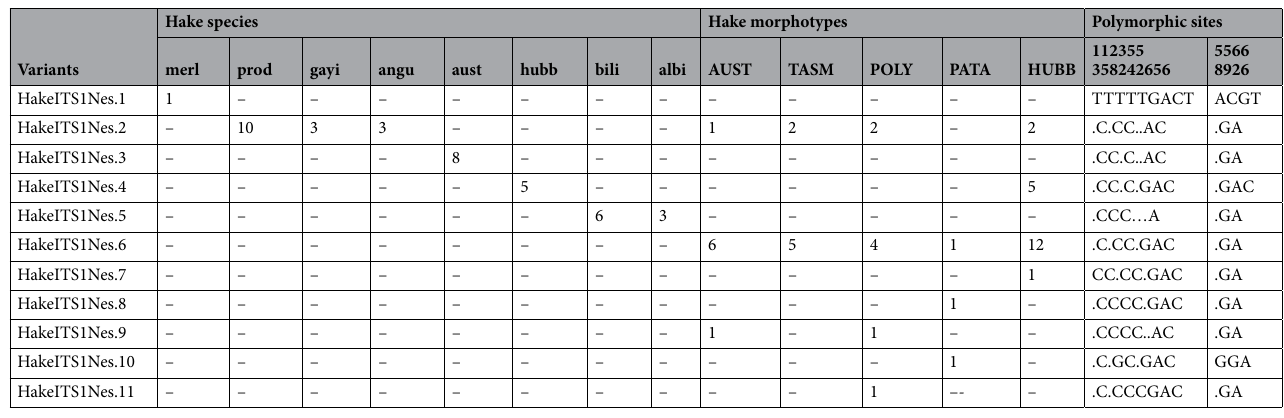
Table 3. Absolute frequency of ITS1Nes variants per species and morphotypes and their polymorphic sites generated with DnaSP v5.10.1 77 . Alpha-numeric codes for ITS1Nes variants are shown ordinal as distinct from full ITS1 variants. Specimen codes are given in Tables 1 and 2.